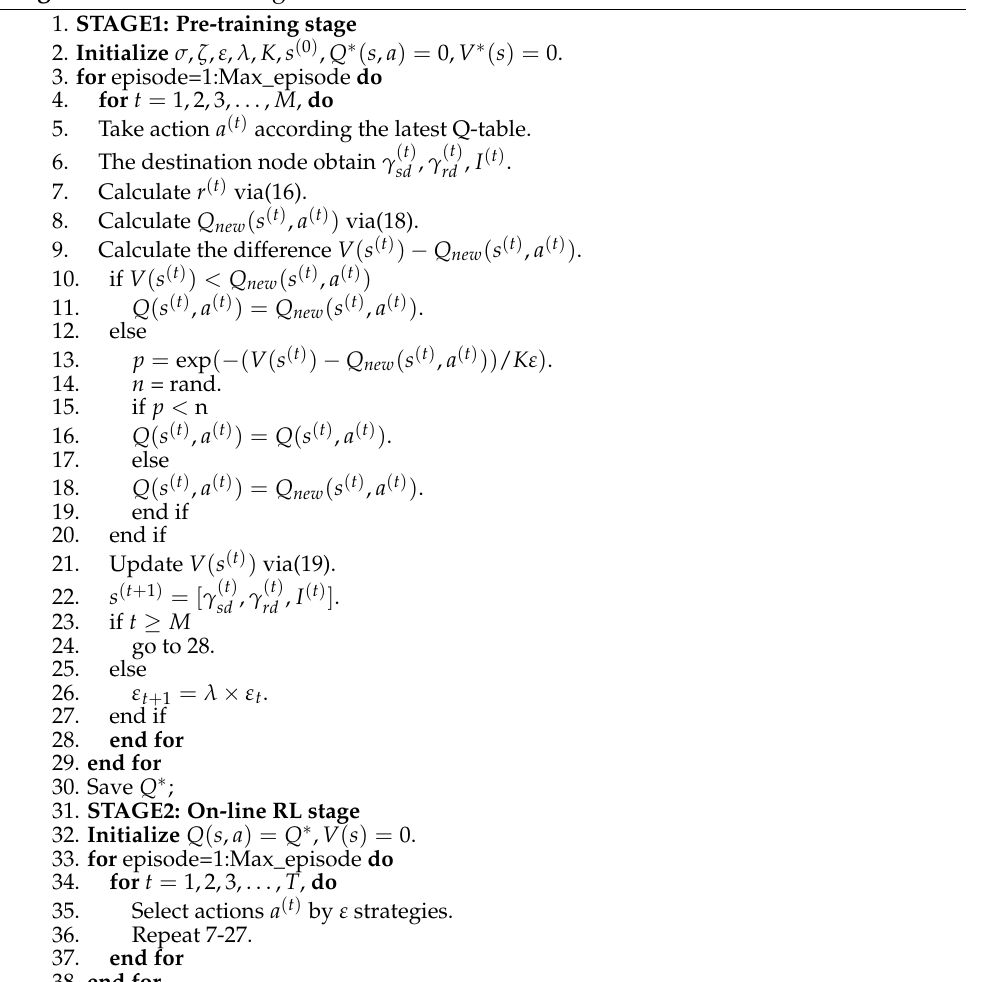
Algorithm 1: SA-FRL